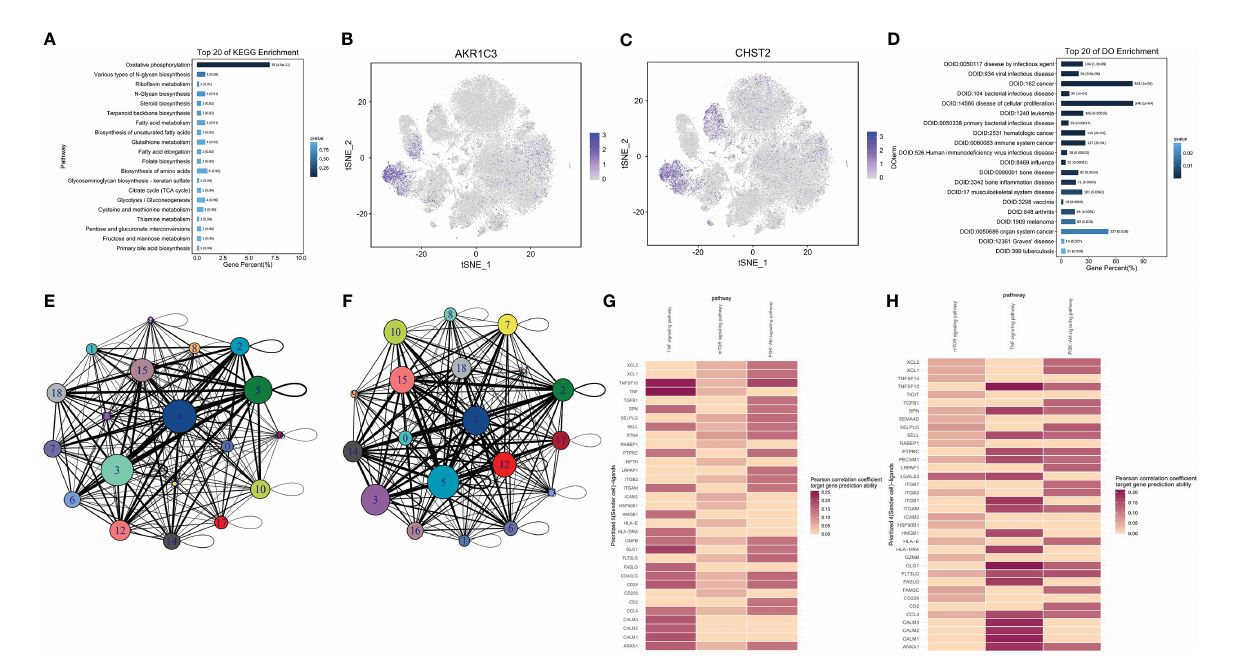
FIGURE 6 Natural killer (NK) cell metabolism analysis. Bar chart showing top 20 of the KEGG pathway in NK cells. Column length represents the percentage of differential genes, and column colors represent Q values (A) . t-SNE plot showing differently expressed genes AKR1C3 (B) and CHST2 (C) in NK cells. Cluster 5 is an NK cell. Each dot represents a single cell; Colors indicate logarithmic transformed P values. Bar chart depicting top 20 of disease ontology enrichment in NK cells (D) . Intercellular interaction network between 18 subsets of control (E) and AA (F) . Molecular interaction states of 36 ligand – receptors between clusters 4 and 5 in the control (G) and AA (H) groups. Molecules in red indicate that the Pearson correlation coef fi cient target gene prediction ability is